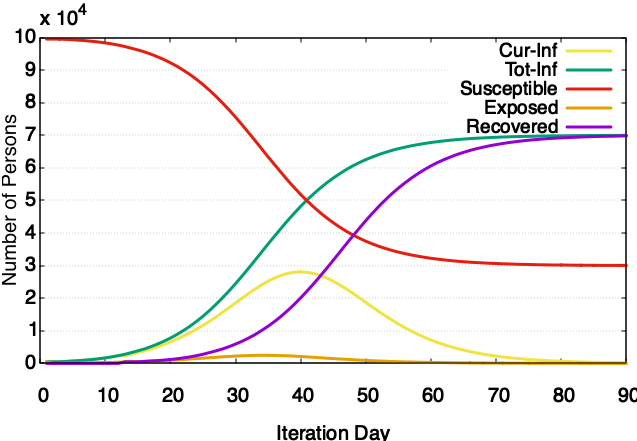
Figure 6. Modeling of SIR using SIM-D. The number of people in different states varies as the simulation progresses through